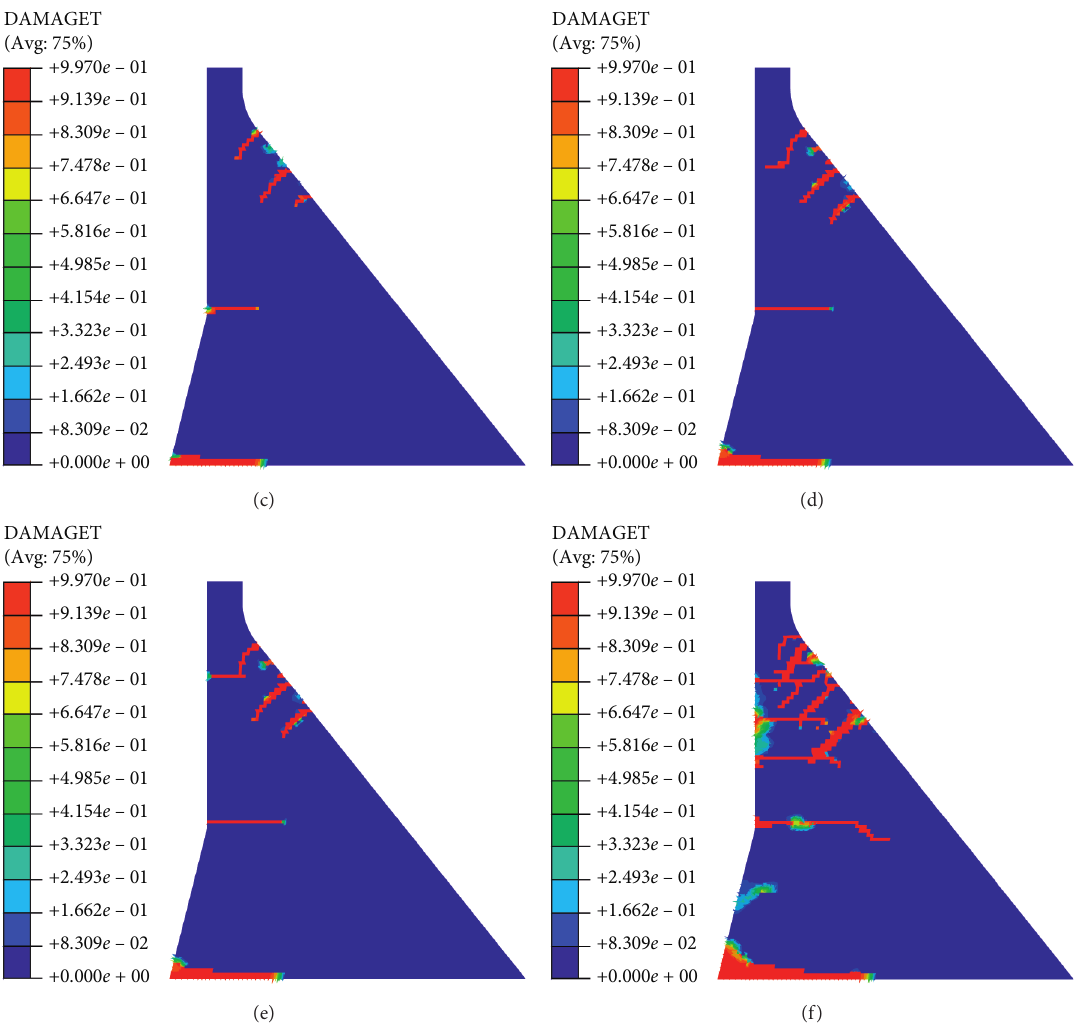
Figure 15: The tension damage-rupture process considering both the tension and compression damage. (a) 1.0. (b) 1.2. (c) 1.4. (d) 1.54. (e) 1.55. (f)